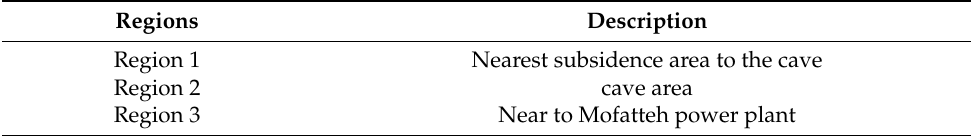
Figure 9. Noabad and Khalatabad stratigraphic columns and selected regions for investigating temporal behavior of displacement. Black squares represent each region.